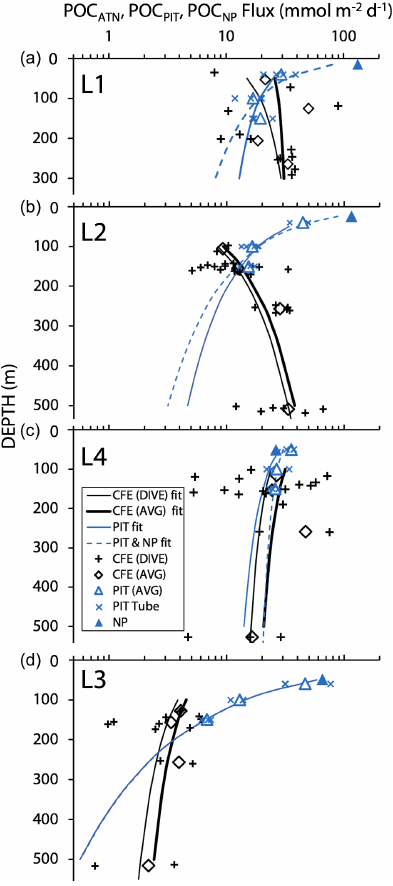
Figure 16. Comparison of CFE, PIT and NP POC flux estimates at the three filament locations L1, L2 and L4 and at L3 in tran- sitional waters. The thin and heavy black lines are the “Martin” curve fit for individual CFE dives (data shown by + ) and for pooled time-averaged data (diamonds), respectively. The solid and dashed blue lines denote Martin curves based on fits to PIT (particle in- terceptor trap) results and to combined PIT result and new pro- duction (NP, solid triangle) data. At L1, the blue curves underes- timate fluxes at 250m by a factor of 2. At L2, blue curves un- derestimate flux by a factor of 6 at 500m. At L4, there was close agreement among methods. At L3 (with sparse data), fluxes were underestimated by a factor of ∼ 2 at 500m. POC ATN flux was cal- culated from volume attenuance flux (VAF, mATNcm 2 cm − 2 d − 1 ), where one VAF unit = 1mmolCm − 2 d − 1 (Bourne et al., 2019). PIT and new-production-based carbon flux (mmolCm − 2 d − 1 ) are from Kranz et al. (2020). The larger scatter in individual CFE dive data compared to PIT data is attributed to the fact that results are representative of 5h of observations vs.